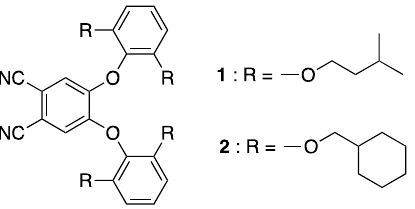
Figure 1. Structure of phthalocyanine precursors 1 and 2.